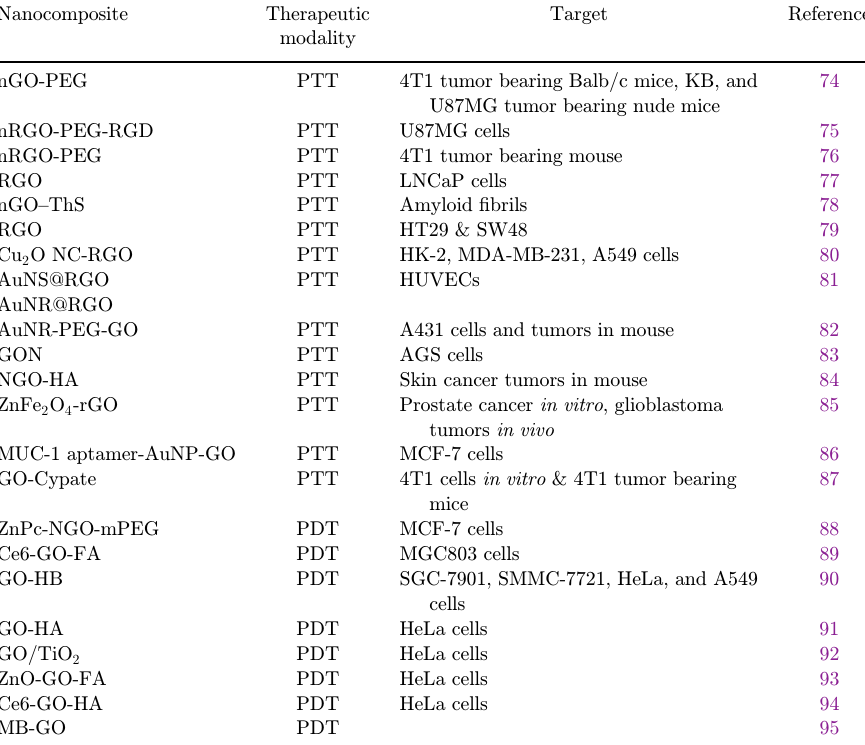
Table 3. Summary of graphene-based nanomaterials for phototherapies.